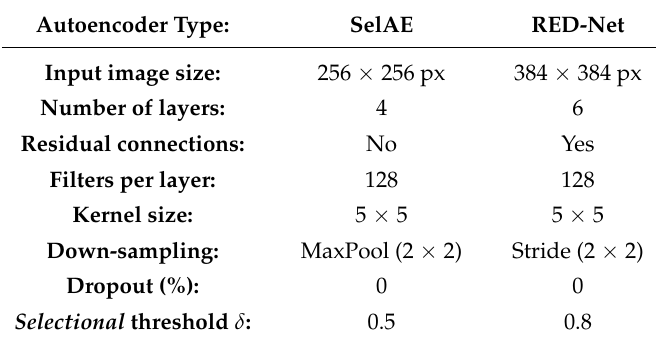
Table 1. Best architectures found after the grid-search